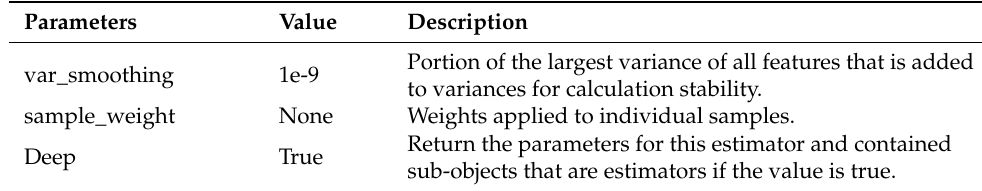
Table 11. Naïve Bayes parameters from scikit-learn library.